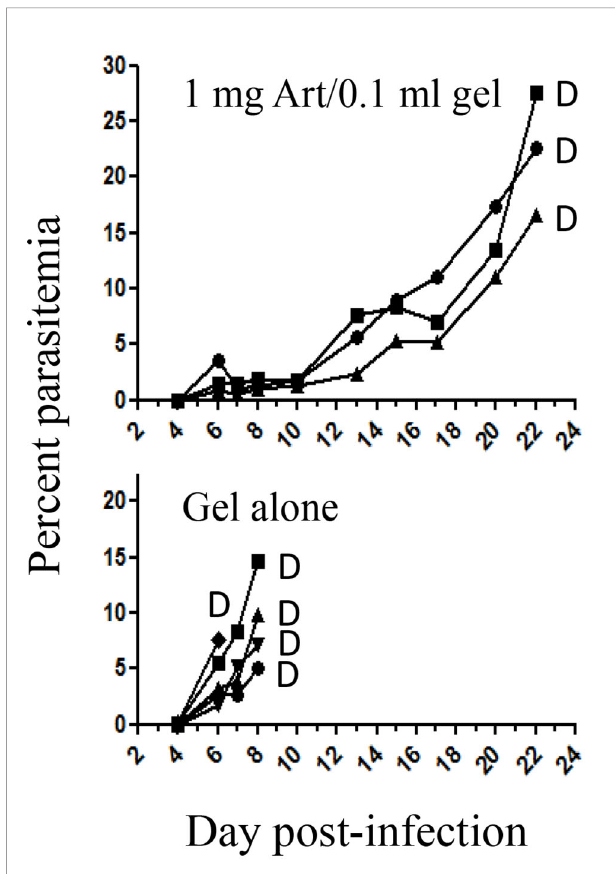
FIGURE 1 | The effect of prophylactic treatment at four days before infection with PbA. Each curve represents one mouse; Art, artemisone; D, death; Gel alone n = 5; Treated n = 3.